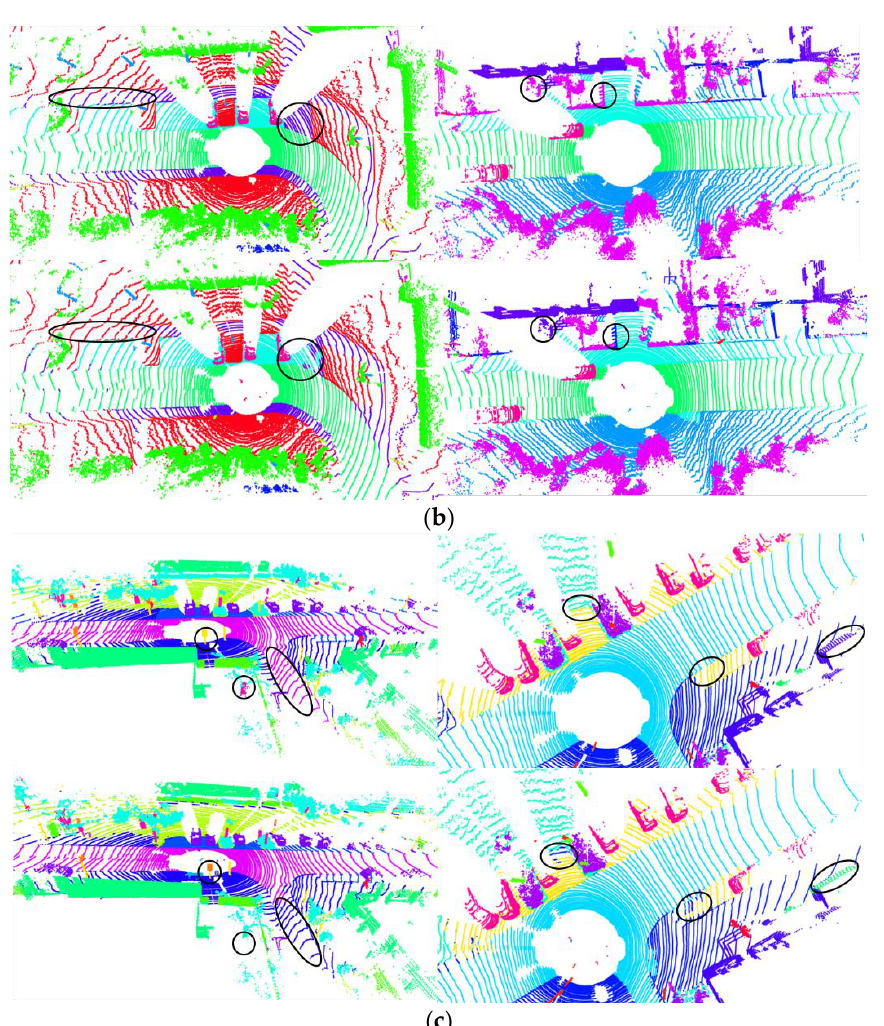
Figure 11. Results of the visualization on SemanticKITTI. First row is the ground truth. Second row shows the prediction results, where an incorrect prediction is circled. ( a – c ) Two different scenarios in the SemanticKITTI dataset. The figure shows the prediction results of six different scenarios in total.